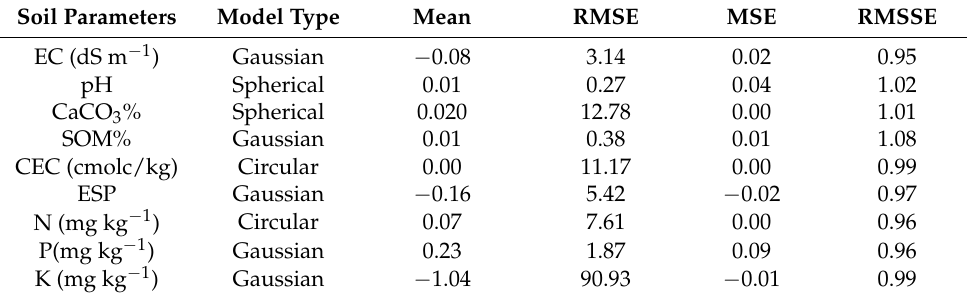
Table 3. Accuracy of geostatistical OK analysis of soil